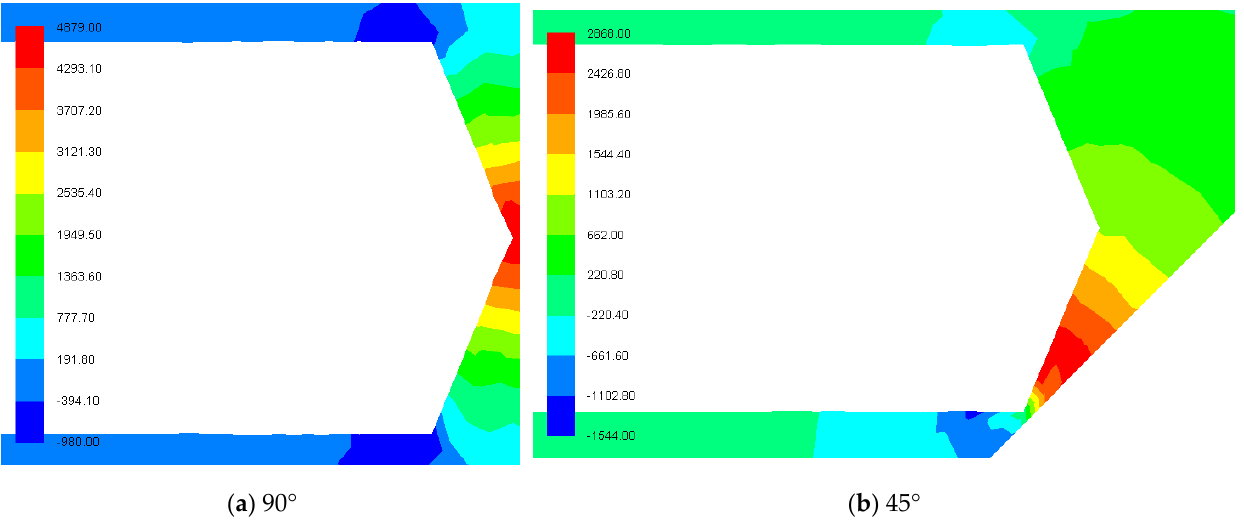
Figure 9. Pressure distribution of the two different shooting angles: ( a ) 90° and ( b ) 45°, at a speed of 10 m/s.